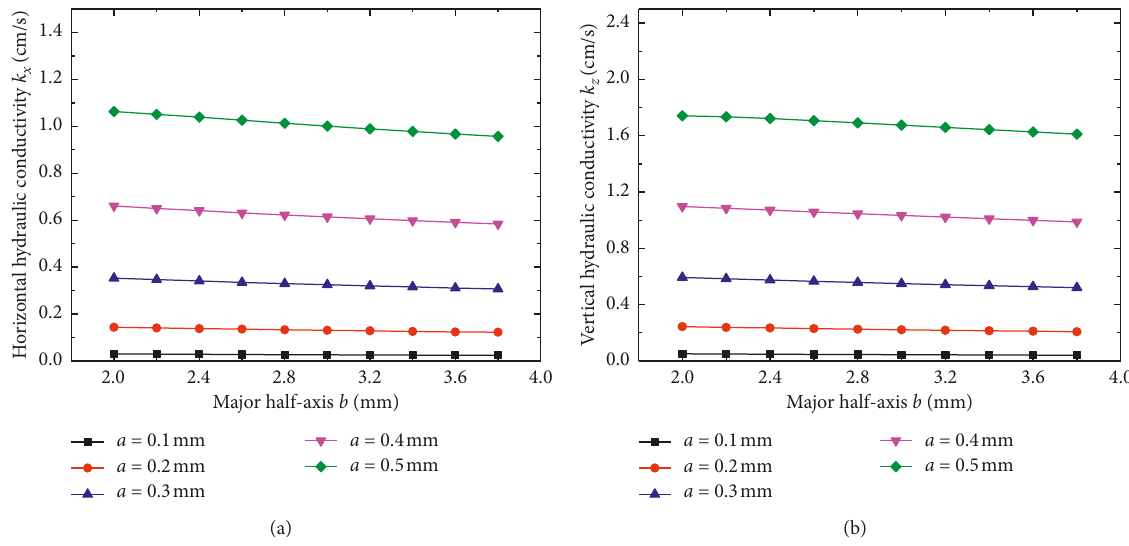
Figure 12: Variation of hydraulic conductivity with particle size under four-particle arrangement. In the same curve, the size of the minor axis of the particles is constant, while the size of the major axis is increasing. (a) Horizontal hydraulic conductivity. (b) Vertical hydraulic